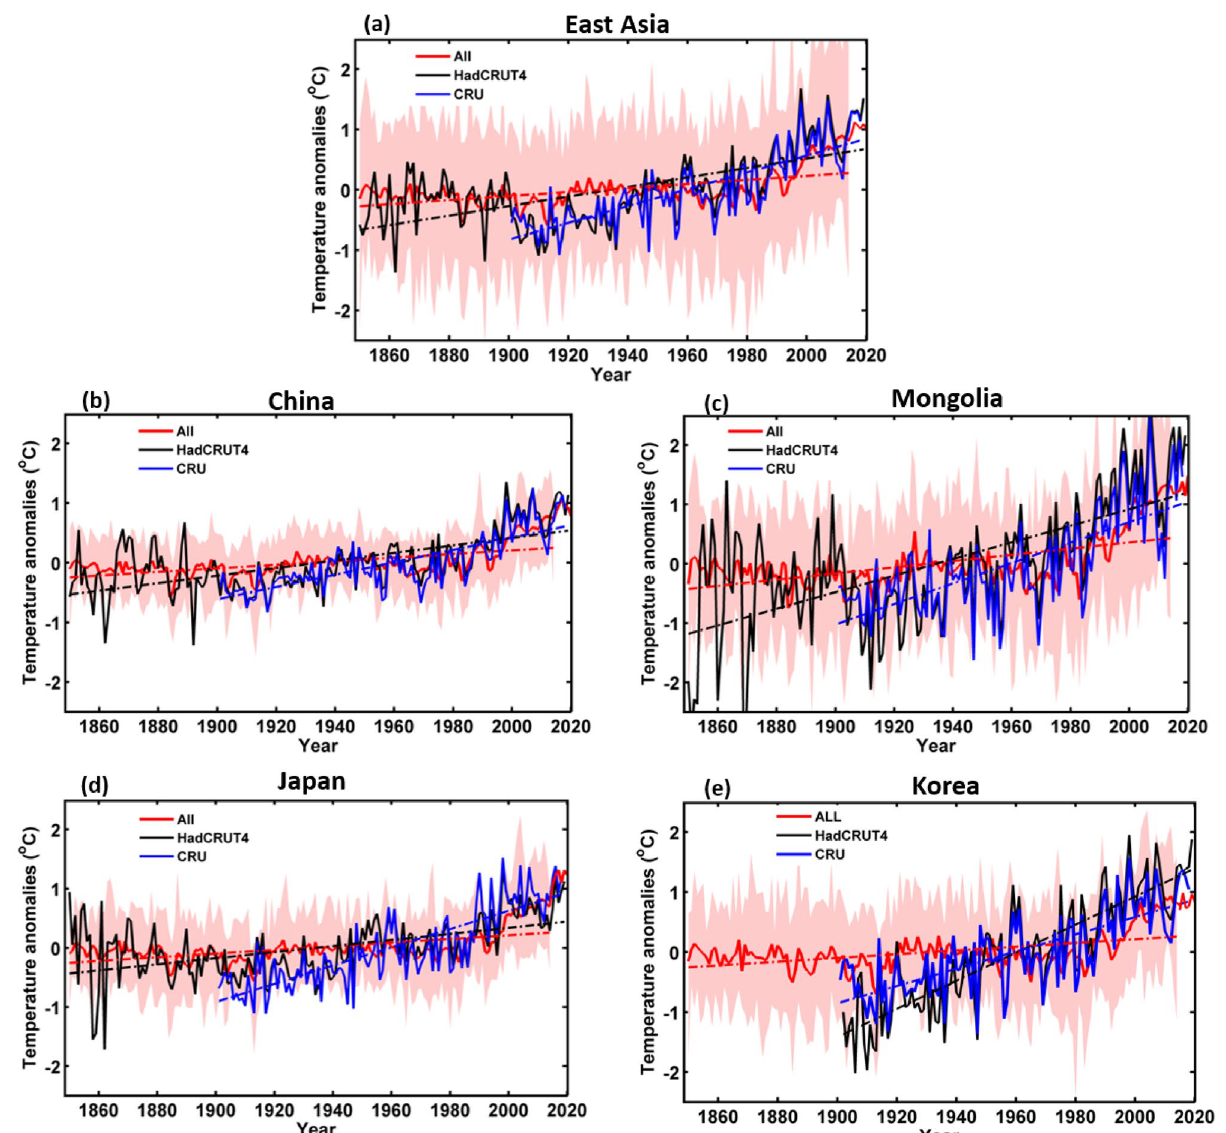
Figure 3. Temporal variation of annual mean temperature anomaly responses to ALL averaged across East Asia and individual countries from observations (CRU and HadCRUT4) and multi-model mean simulations (CMIP6) for the period 1850–2014 (CRU: 1901–2018, HadCRUT4: 1850–2019). Shaded bands are multi-model